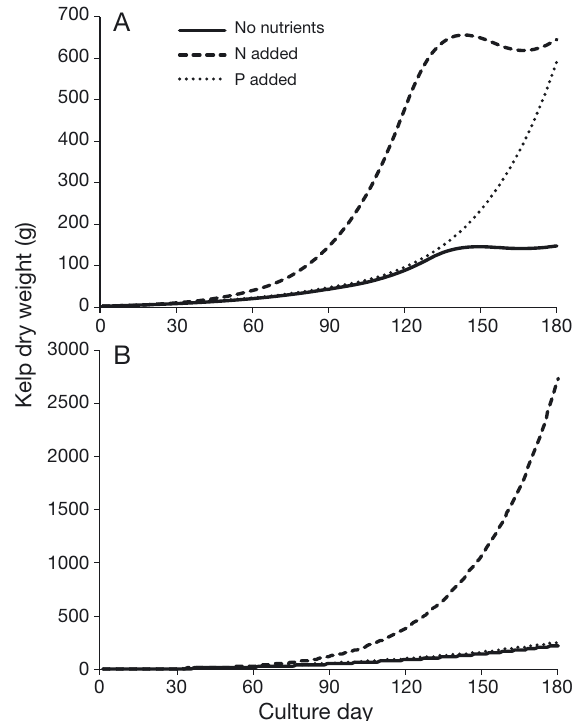
Fig. 8. Simulation results on the potential effect of fertilization with dissolved inorganic nitrogen (N) or phosphorus (P) on the